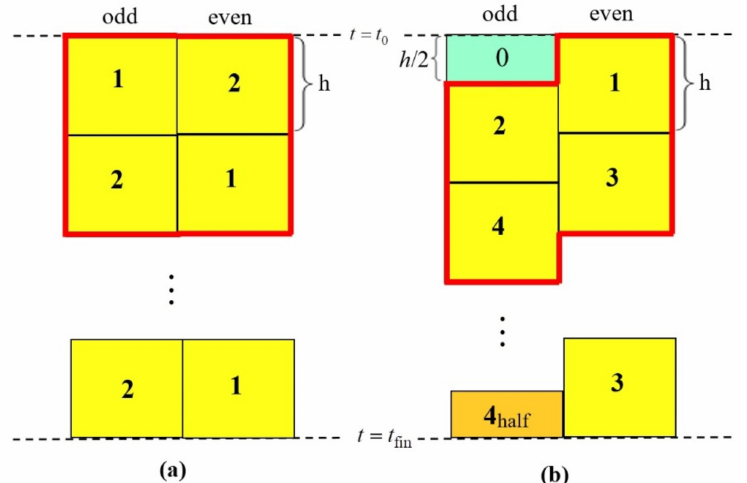
Figure 2. The diagram of the odd-even hopscotch structures for two nodes. The numbers in the boxes represent the different formulas, whereas the areas surrounded by thick red lines are the repeating units. ( a ) The original OEH algorithm. ( b ) The new leapfrog-hopscotch structure. The green and orange boxes are non-repeating